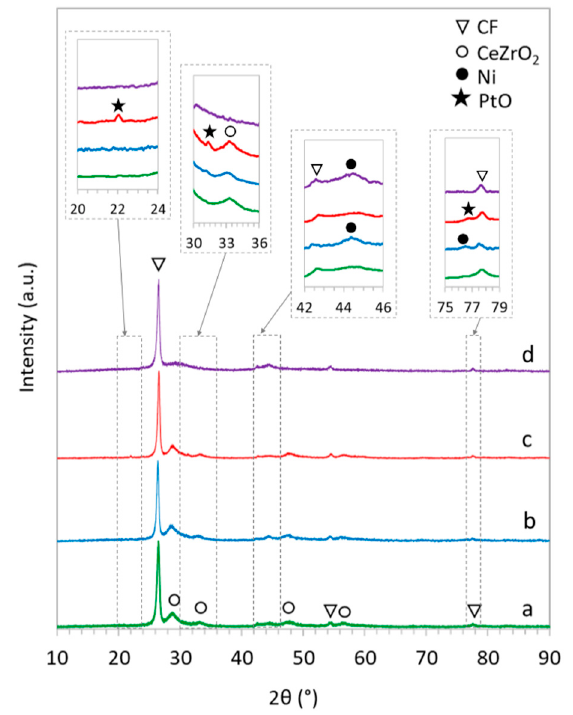
Figure 13. X-ray diffraction (XRD) patterns of spent catalysts denoted CZ/CFF(s), Ni-CZ/CFF(s), Pt-CZ/CFF(s) and Pt-Ni-CZ/CFF(s).